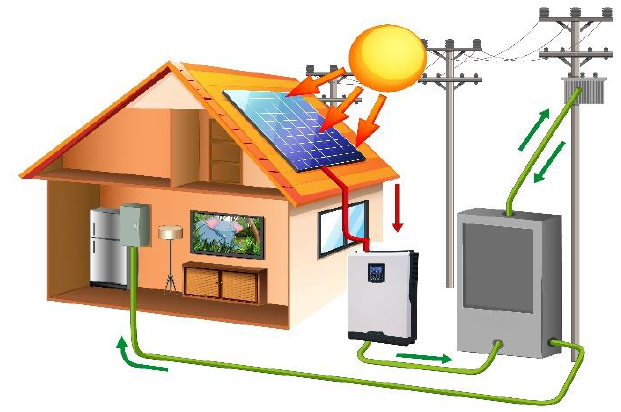
Figure 1. Structure of a typical nanogrid system.